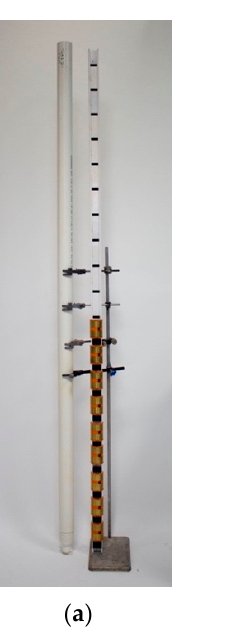
Figure 2 Exploded All-in-One probe block diagram Figure 4. ( a ) The EnviroSCAN probe; ( b ) Probe’s components [44].